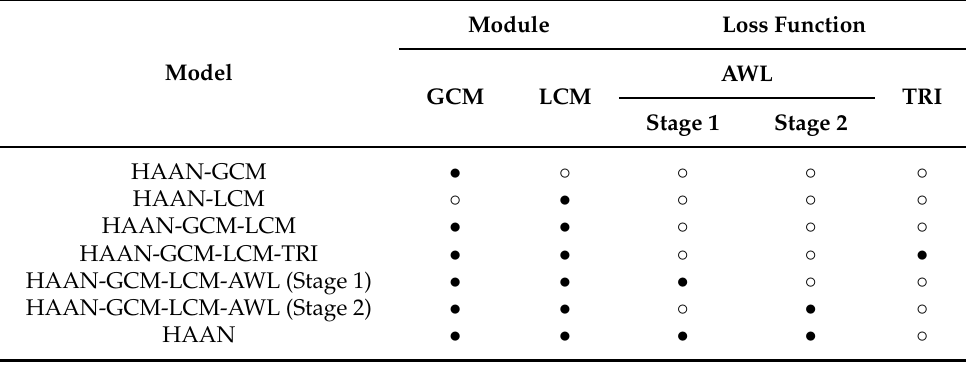
Table 5. Experimental configurations of different ablative models.